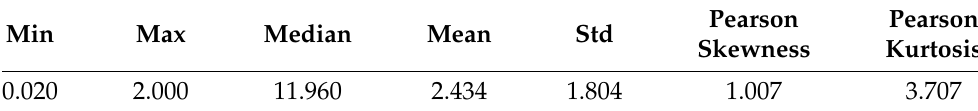
Table 3. Summary statistics for annual wind